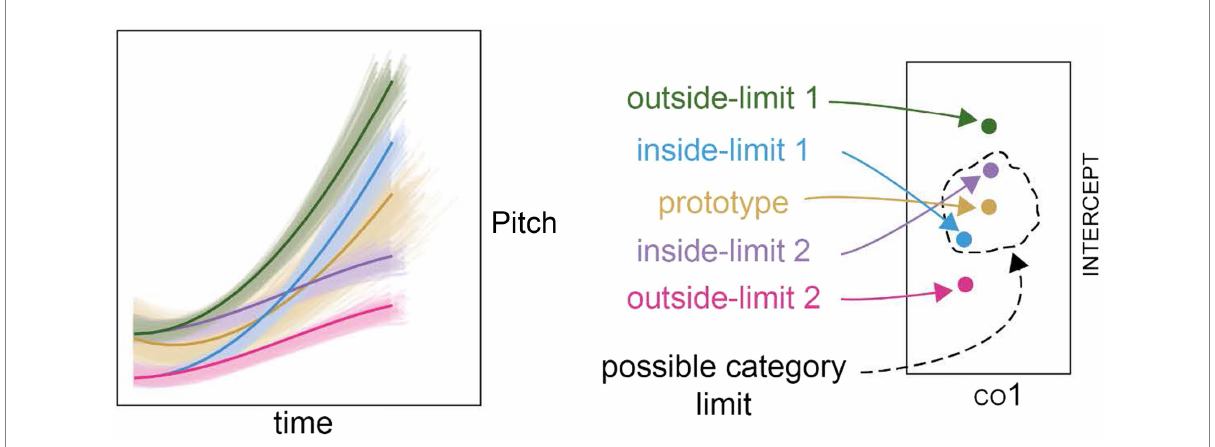
FIGURE 3 The contour shapes for the referents and neighboring exemplars; gold-prototype referent and the corresponding prototype referent set, blue and purple-two inside-limit non-prototype referents and the corresponding non-prototype referent sets; green and pink-two outside-limit non- prototype referents and the corresponding non-prototype referent